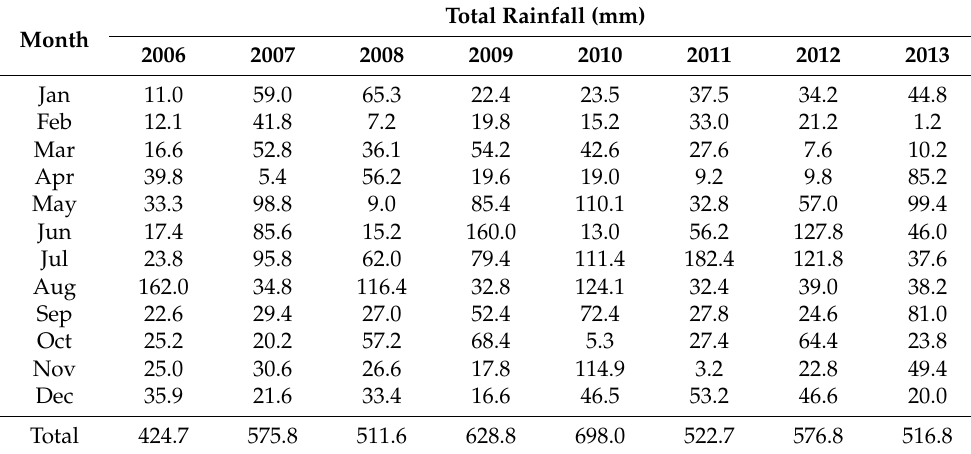
Table 2. Total precipitation recorded in 2006–2013.